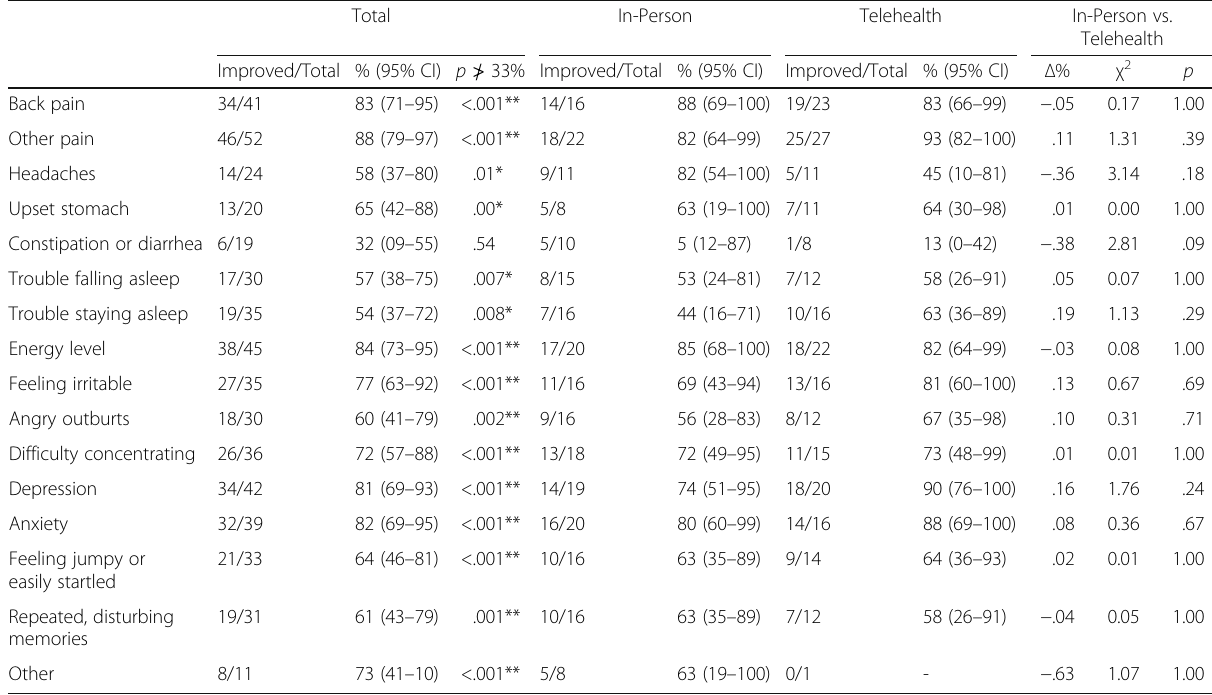
Table 3 Improvement Total In-Person Telehealth In-Person vs.